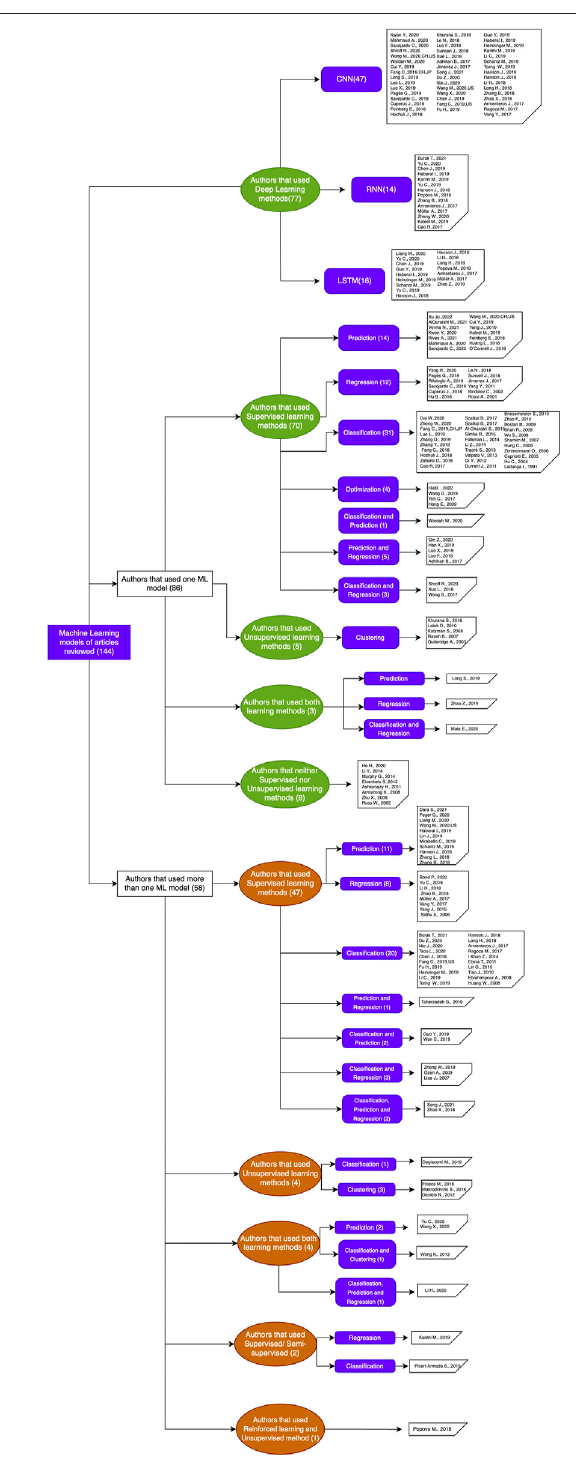
FIGURE 4 | Machine Learning paradigms: superviser learning, unsupervised learning, reinforcement learning.